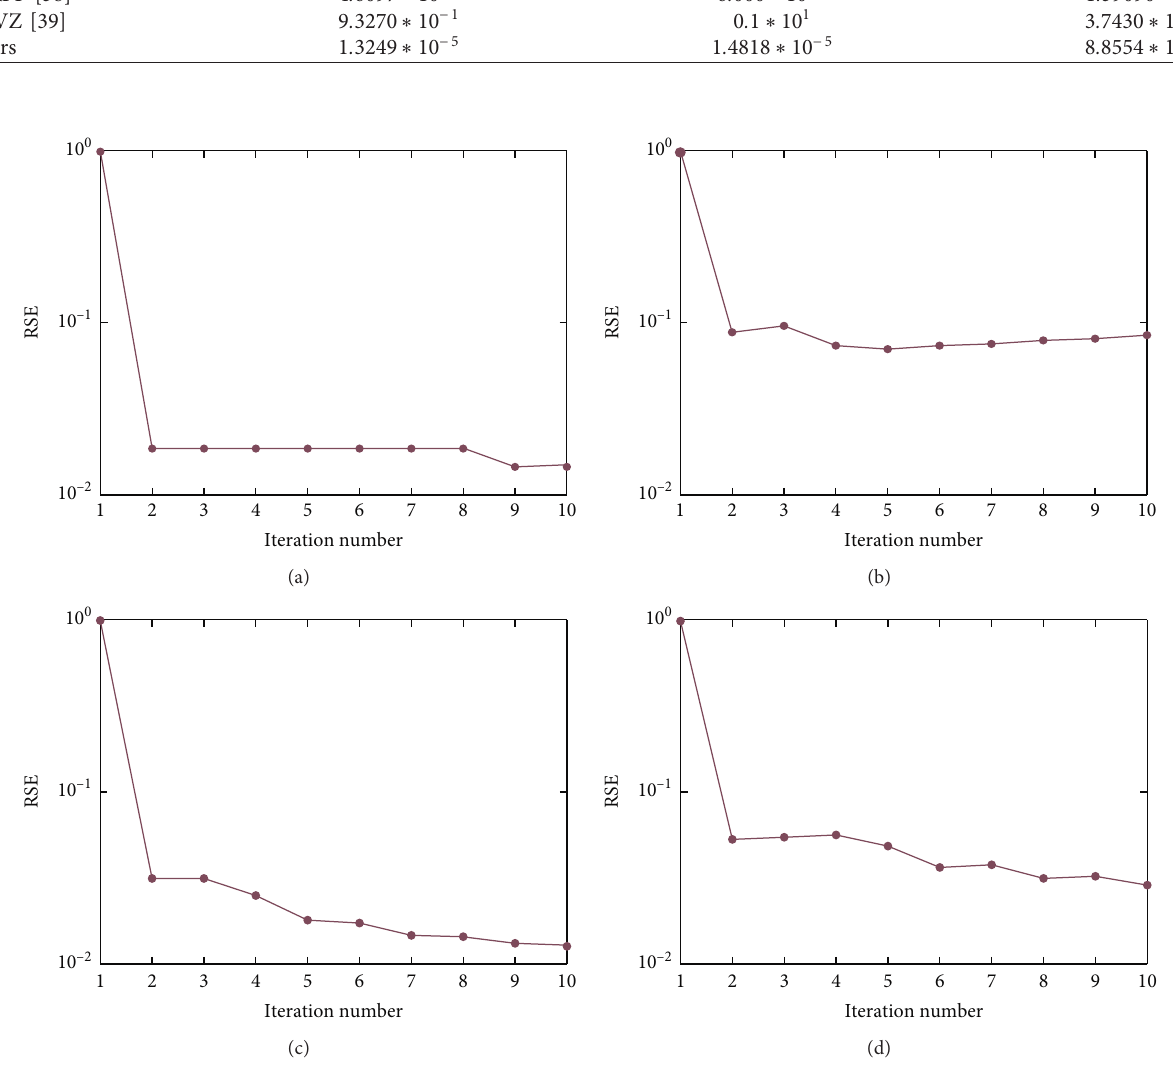
Figure 3: Root mean square error: (a) video face images; (b) complicated windows; (c) dummy face images; (d) handwritten images.